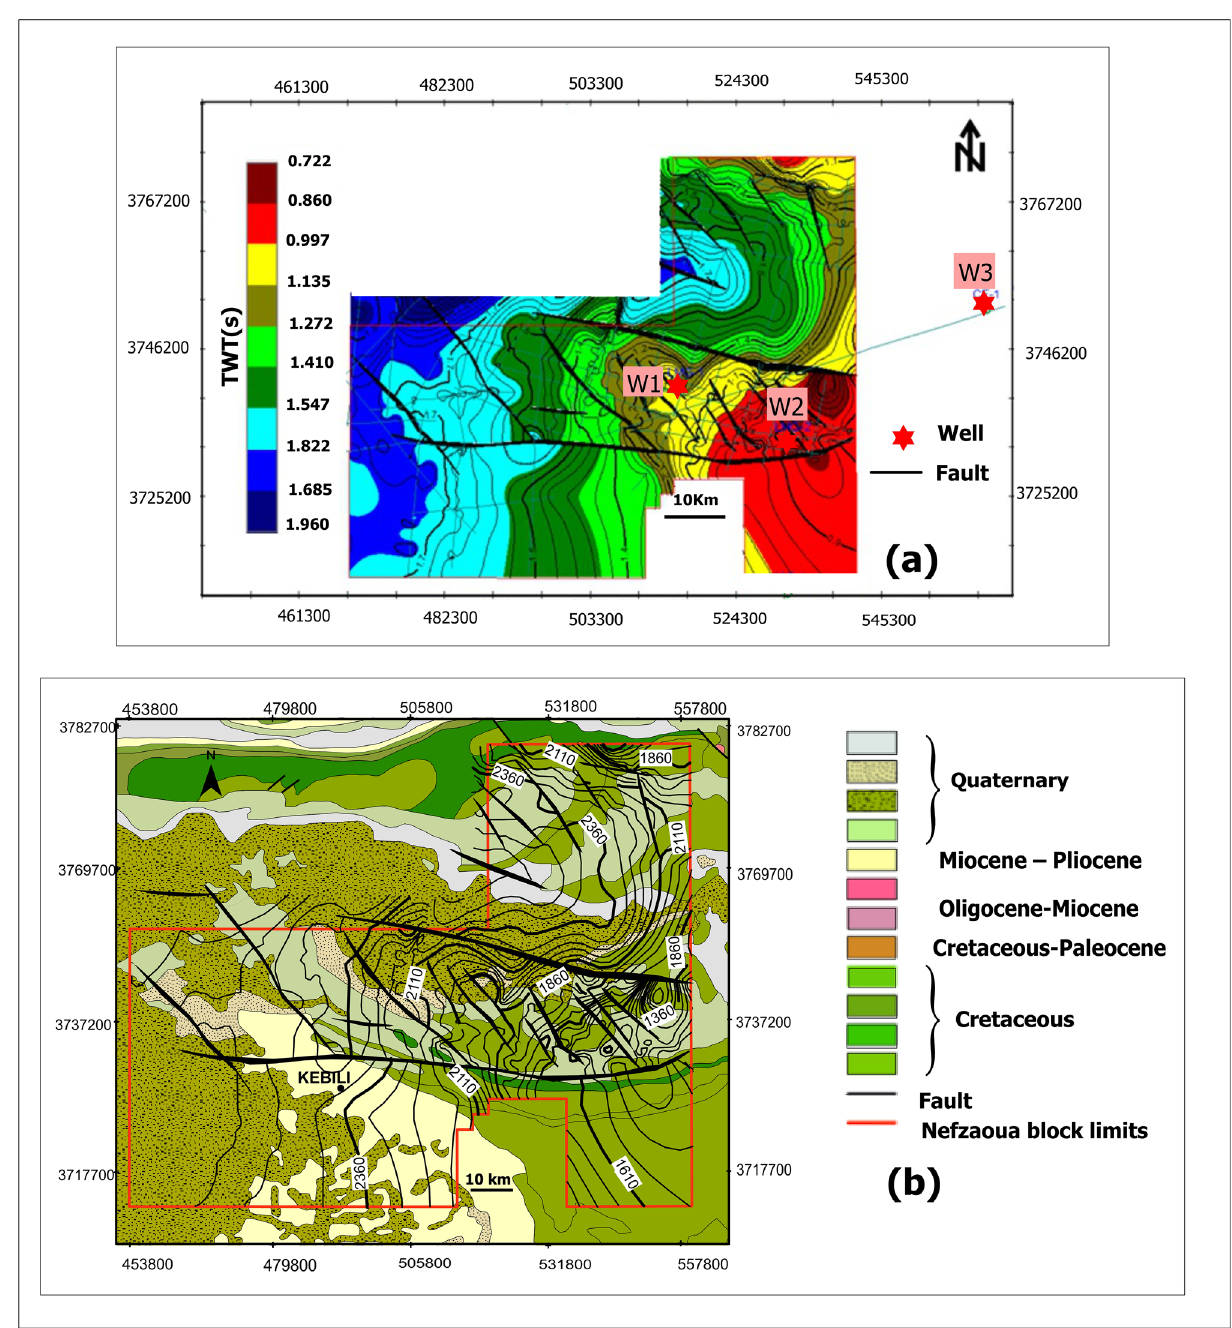
Fig. 9 The top Jurassic series maps. a The isochrones map. b The isobaths